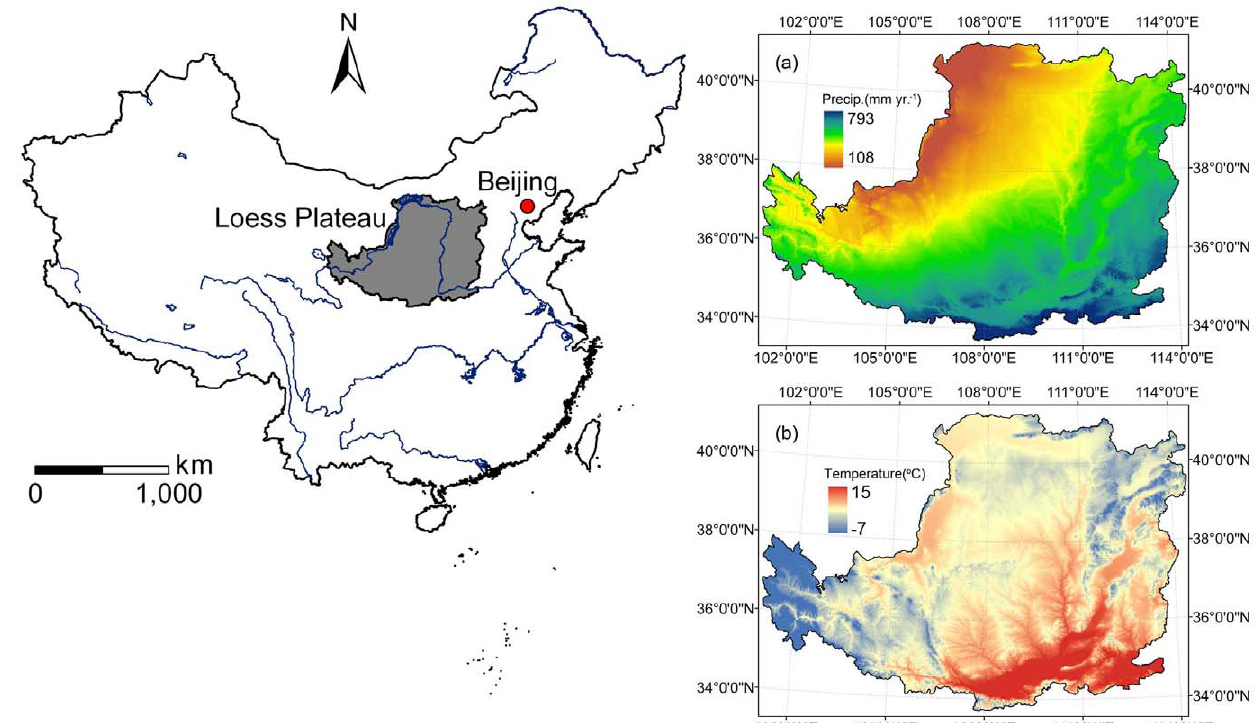
Figure 1. Location of the Loess Plateau and average climate conditions from 1999 to 2008. (a) Precipitation (b) Temperature.